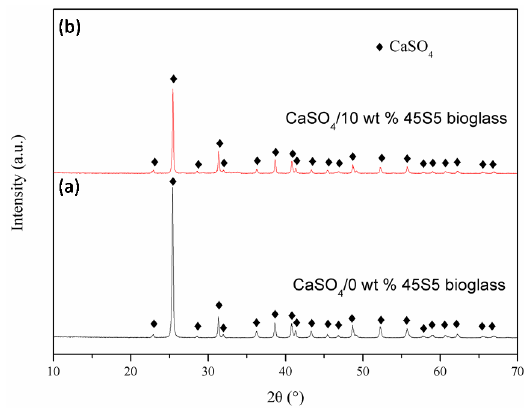
Figure 2. XRD patterns of the CaSO 4 scaffolds with ( a ) 0 wt % and ( b ) 10 wt % 45S5 bioglass.